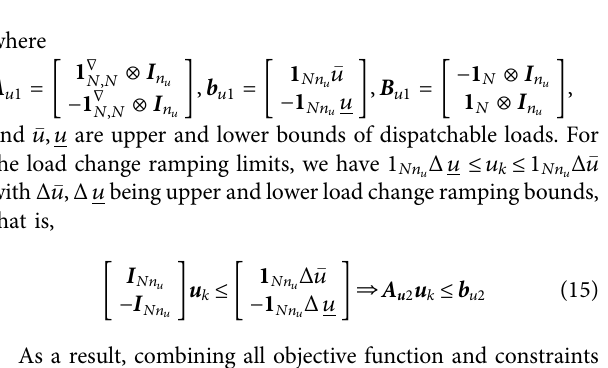
Frontiers in Energy Research |